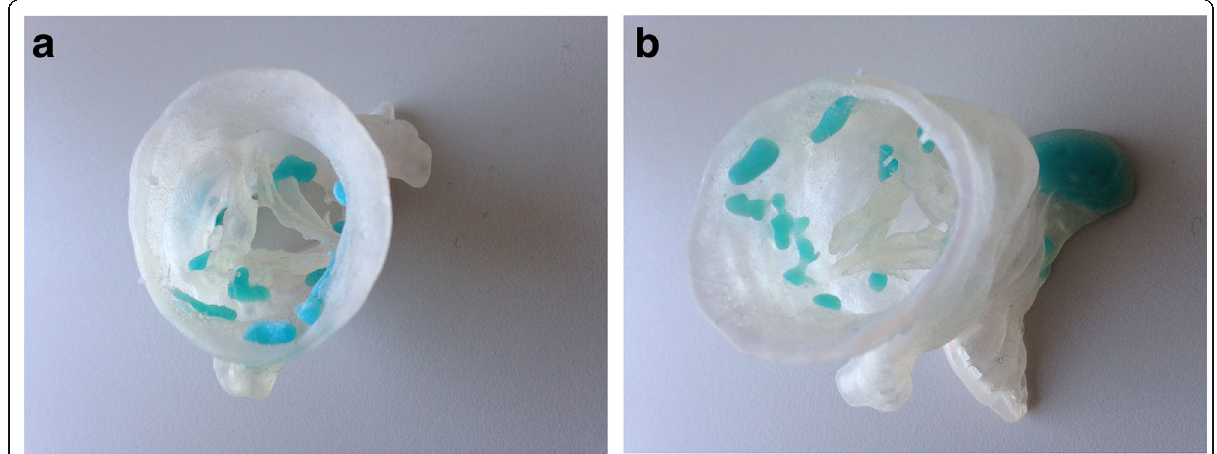
Fig. 4 a , b Examples of prints of the aortic valve in a flexible transparent material with calcifications in blue non-flexible